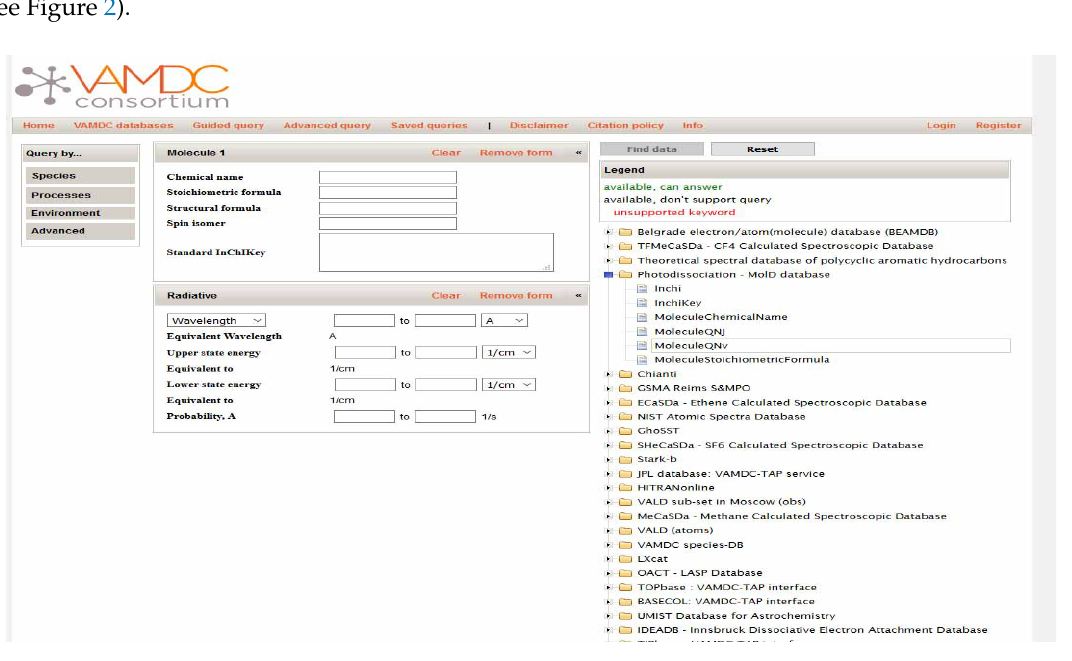
Figure 2. Snapshot from the query page from the Virtual Atomic and Molecular Data Center (VAMDC)